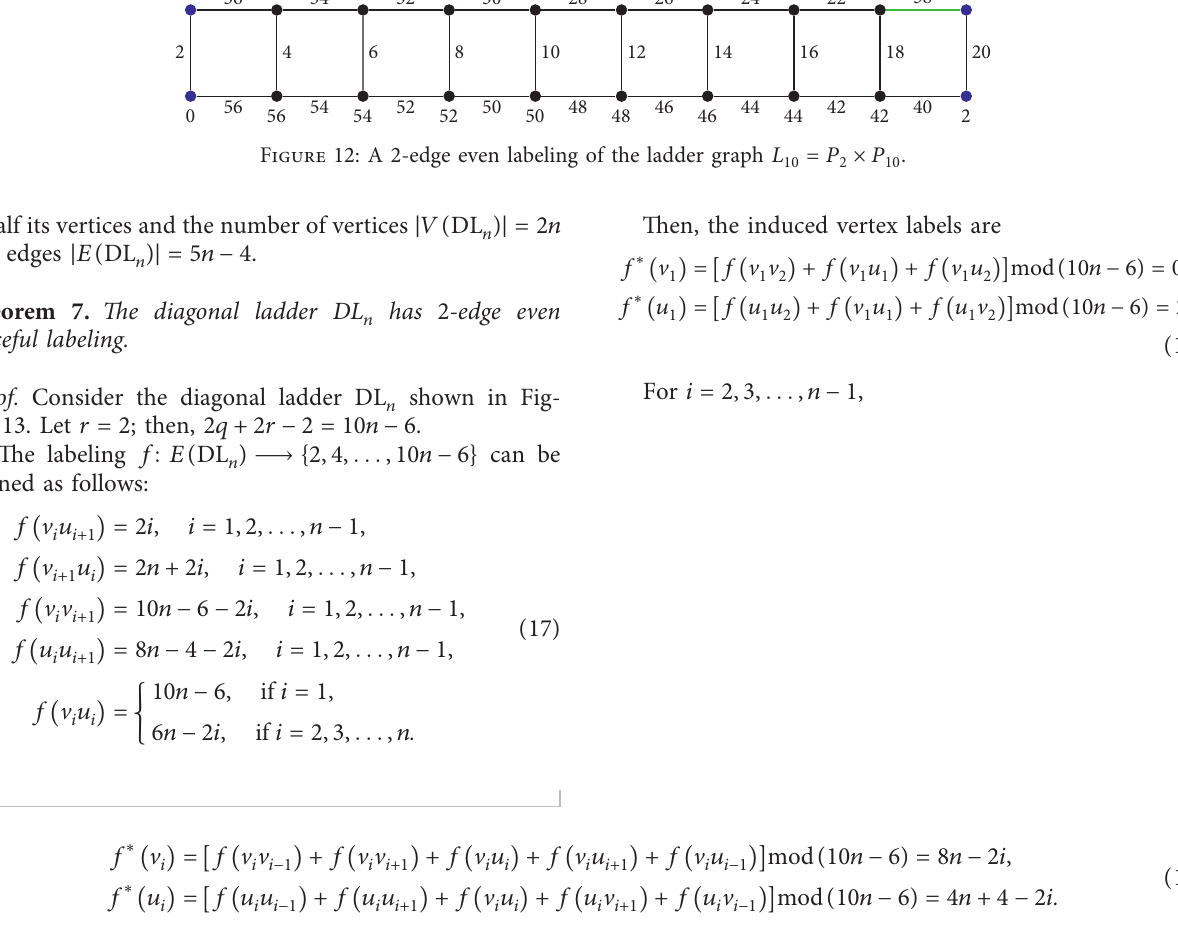
� P × P n n with ordinary labeling. 2